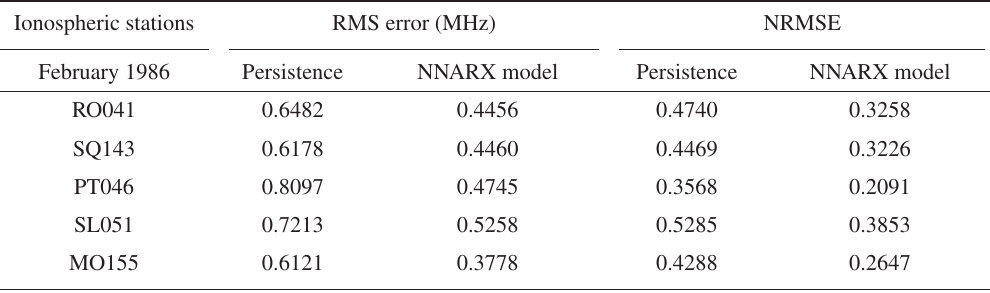
Table III. RMS and NRMS errors at different stations for February